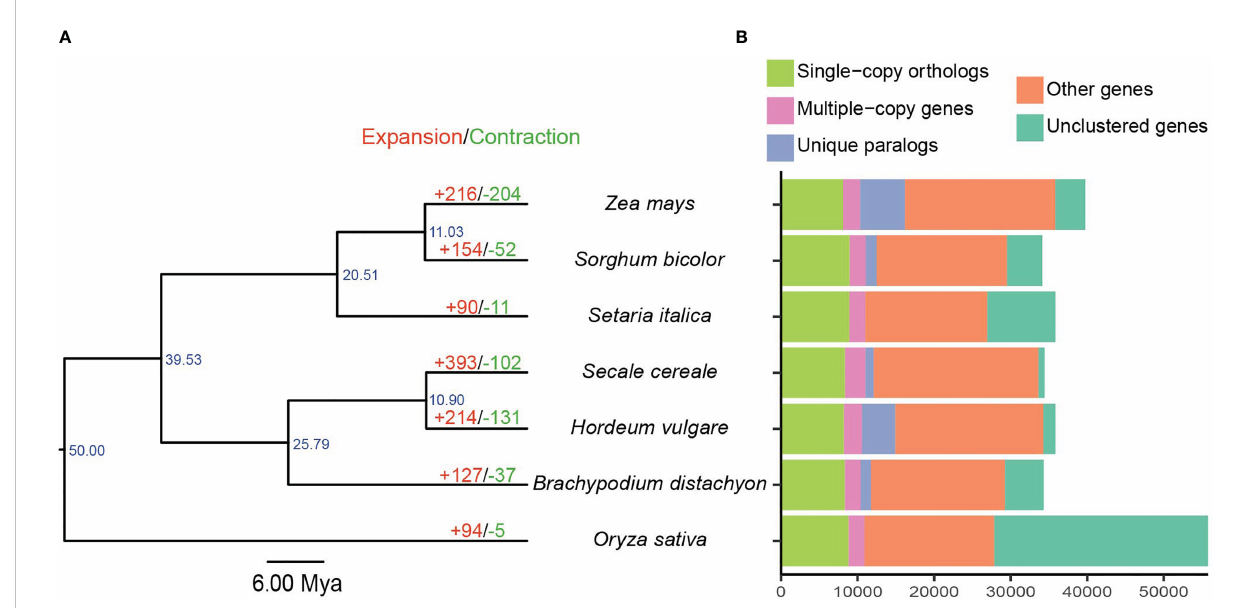
FIGURE 2 Gene clustering and species phylogenetic analysis. (A) Phylogenetic tree, divergence time, and gene family expansions/contractions among seven Poaceae species. Scale bar corresponds to 6 Mya. (B) Distribution of homologous